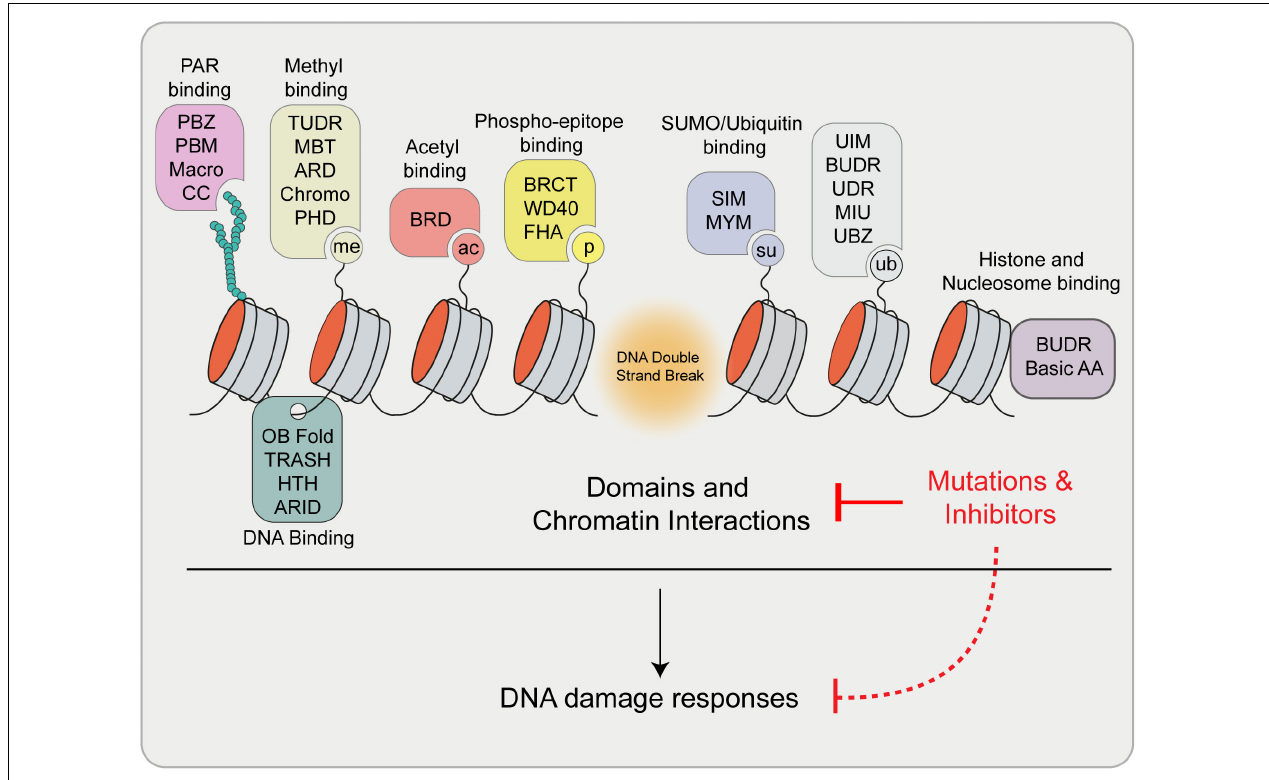
FIGURE 6 | Summary of reviewed and highlighted interaction domains involved in the DDR. Upon DSB formation, many signals are generated that are recognized by specific domains within proteins involved in DNA damage signaling and repair. These proteins engage break sites and chromatin through these interactions to exert their function. Mutations and/or the use of inhibitors of these domains have the potential to disrupt these interaction and pathways, which may impact downstream DDR processes. Definitions: PBZ, PAR Binding Zinc finger; PBM, PAR Binding Motif; CC, Coiled coil; ARD, Ankyrin Repeat Domain; MBT, Malignant Brain Tumor Domain; PHD, Plant Homeodomain; BRD, Bromodomain; BRCT, BRCA1 C-terminus domain; FHA, Forkhead-associated domain; SIM, SUMO Interacting Motif; MYM, MYeloproliferative and Mental retardation; UIM, Ubiquitin Interaction Motif; BUDR, BARD1 ubiquitin (Ub)-dependent recruitment and BRCT-associated ubiquitin-dependent recruitment; UDR, Ubiquitin-Dependent Recruitment domain; MIU, Motif Interacting with Ubiquitin; UBZ, Ubiquitin Binding Zinc finger; OB Fold, Oligosaccharide-Binding Fold; TRASH, Trafficking, Resistance, And Sensing Heavy metals domain; HTH, Helix Turn Helix; ARID, A–T Rich Interaction Domain; Basic AA, Arginine